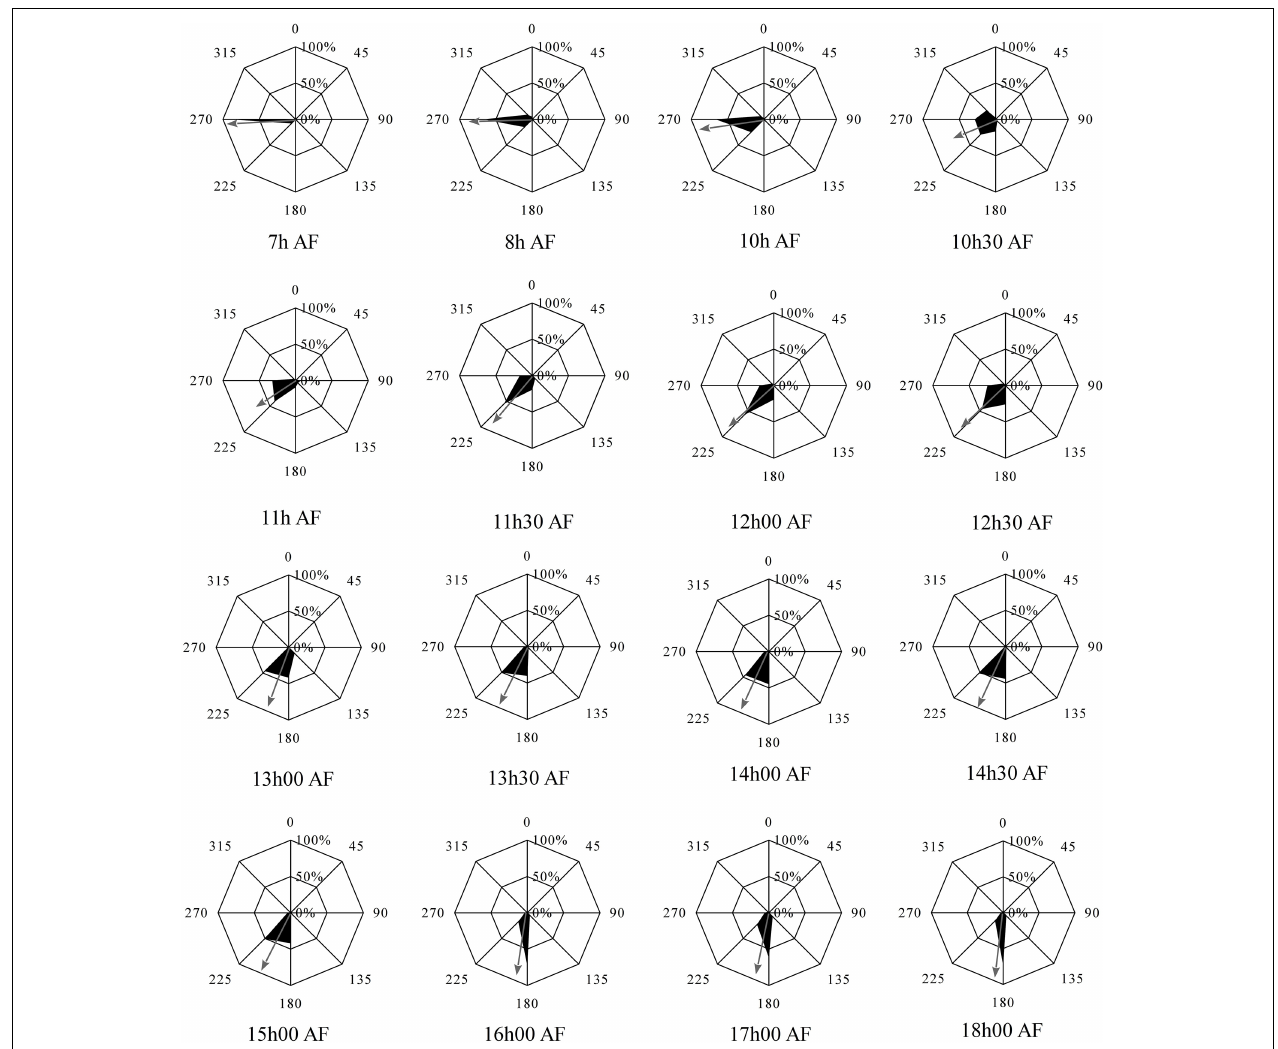
FIGURE 2 | Influence of 90 ◦ reorientation experiments on the direction and sense of polarization vector. Second order mean of the direction and sense of the polarization vector after 90 ◦ reorientation is depicted by an arrow. Length of the arrow represents the r measure of the second order mean angle. Percentages represent the fraction of the population that shows